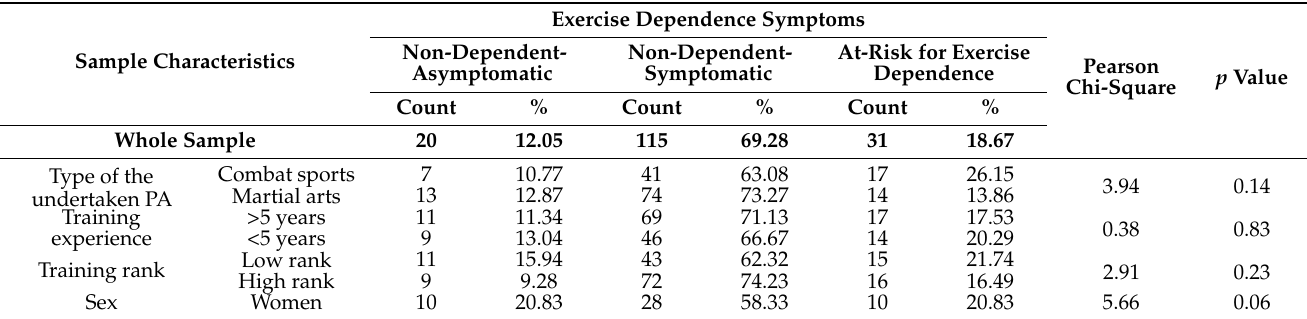
Table 7. The prevalence of the three categories of EDS among respondents.